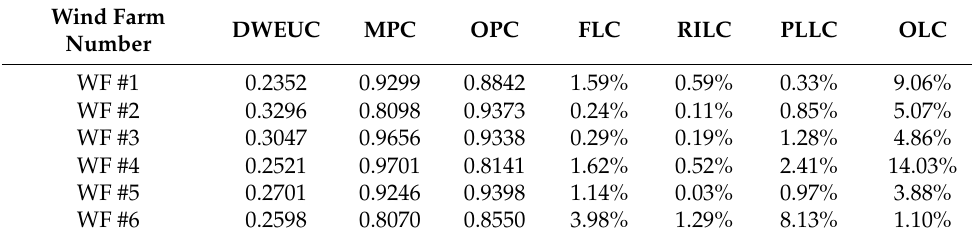
Table 8. The calculation results of comparative indicators of wind farms.